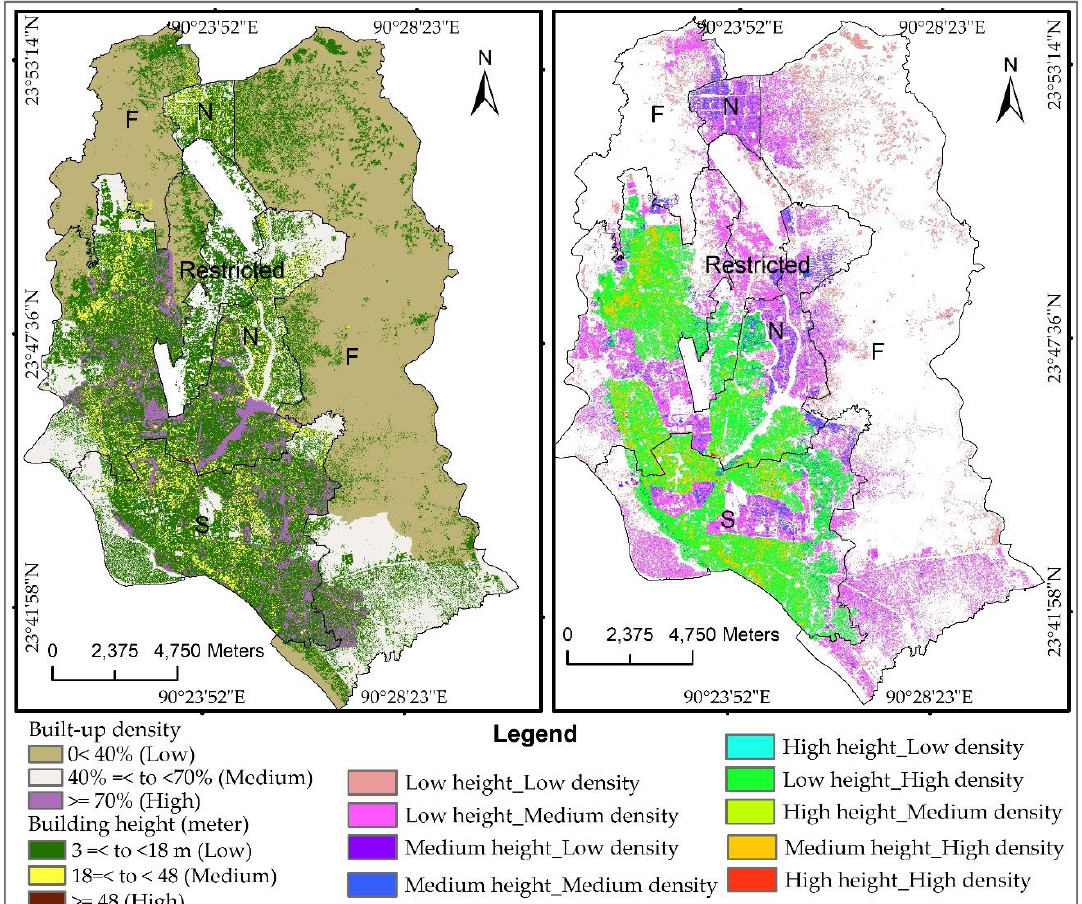
Figure 12. The left side shows the built-up density and building height, while the right side shows the building type based on building height and density. In the map N, S, and F, refer to DNCC, DSCC, and fringe area,